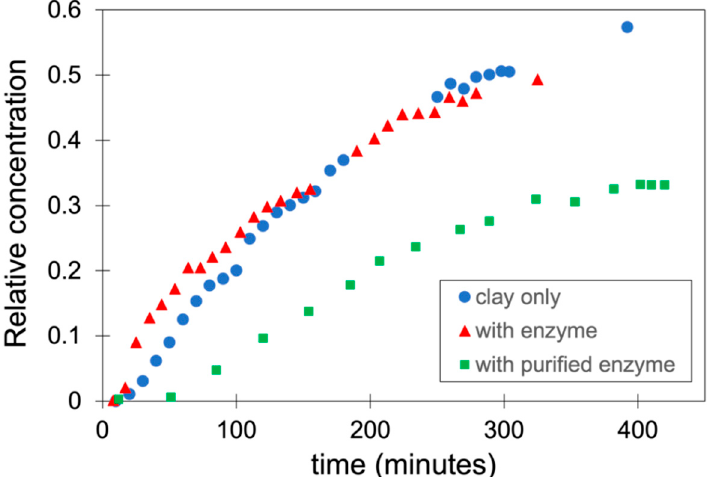
Figure 8. Breakthrough curve of TC in the biogeofilter made with thermally treated clay at 300 °C (blue), with addition of commercial solution form of enzyme, immobilized on the surface of the stevensite clay (red), and with purified enzyme in laboratory conditions, also immobilized on the surface of the stevensite clay (green).